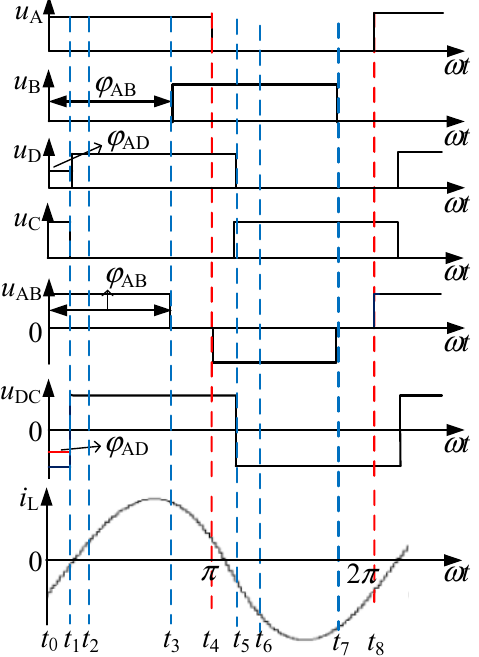
Figure 3. Work waveform under EPS modulation.